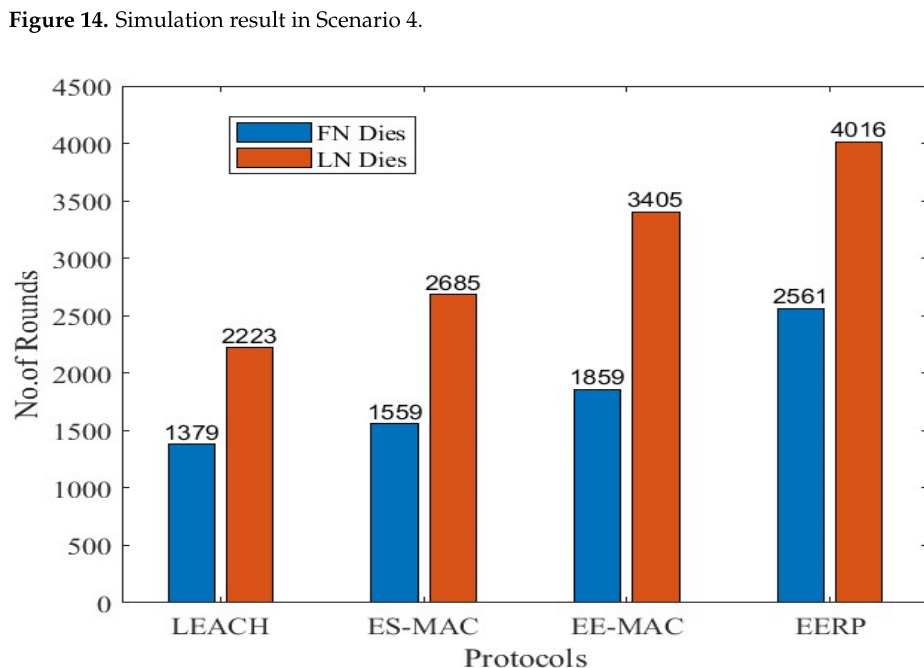
Figure 15. FN and LN deaths in Scenario 4.